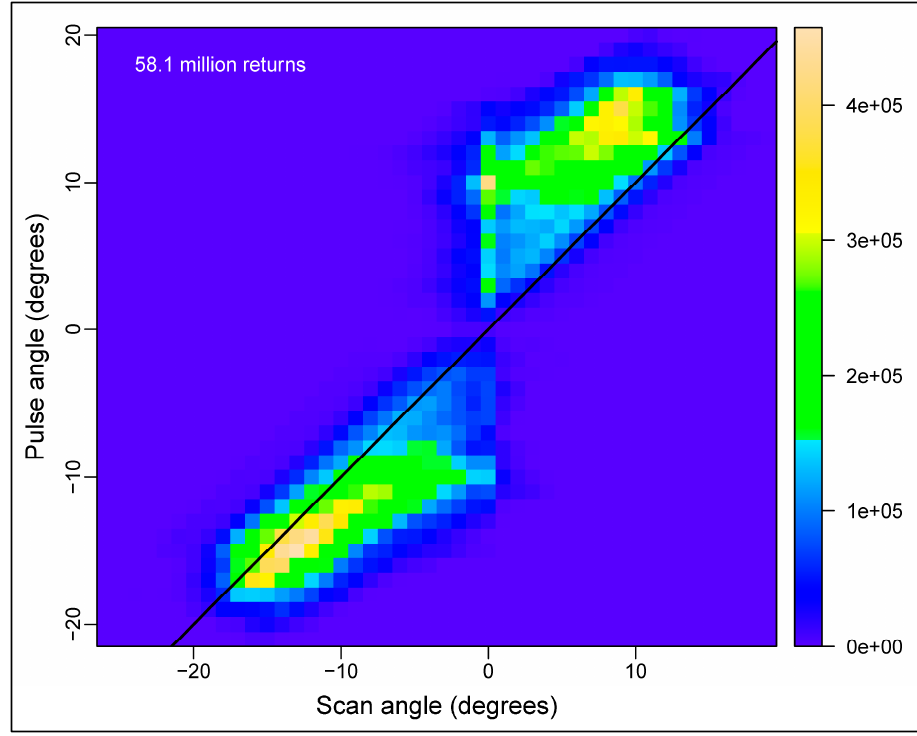
Figure A4. Two-dimensional histogram of a scan swath from the Colville area, depicting correspondence between recorded pulse scan angle and computed pulse angle. 1:1 line in black.